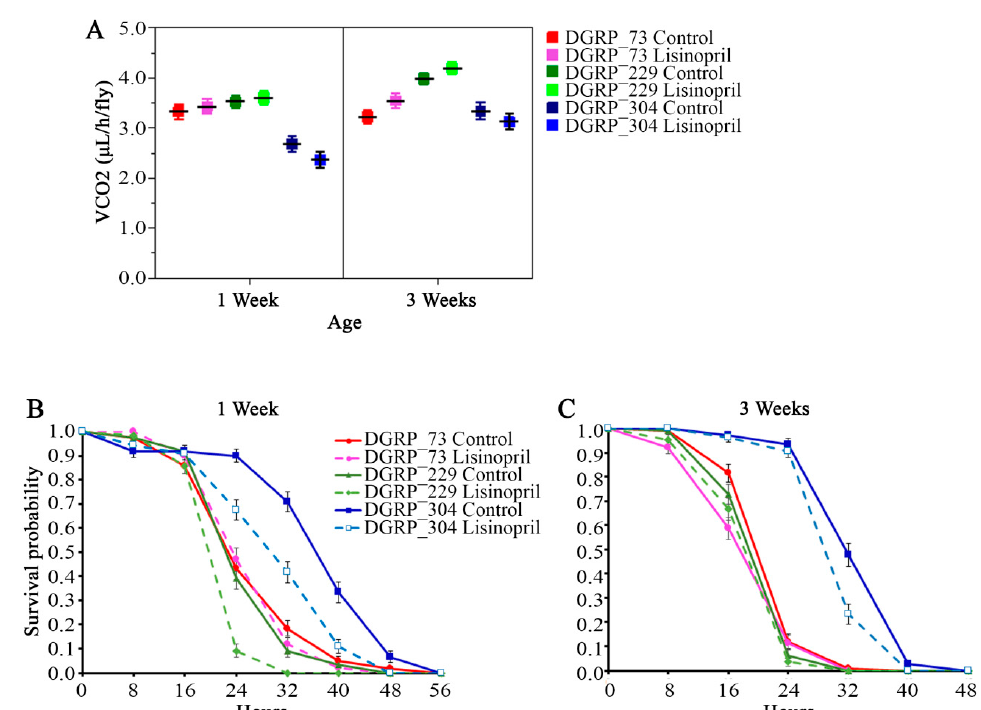
Figure 6. Lisinopril negatively affects survival under nutrient starvation but the effect of the drug can be blunted by genotype and age. ( A ) There is no significant effect of Lisinopril on resting metabolic rate (F 1,106 = 0.14, p = 0.7082). Values represent the least-square means of whole-body CO 2 production, an index of resting metabolic rate, adjusted for live body weight ( n = 10 independent replicates). ( B , C ) Kaplan–Meier survival probability curves for one-week-old (panel B ) and three-week-old (panel C ) DGRP flies fed Lisinopril or control food. There is a significant genotype-by-age-by-Lisinopril interaction effect on survivorship (Wald χ 2 = 7.53, p = 0.0061) in the analysis of pooled data. DGRP_229 and DGRP_334 fed Lisinopril are significantly more sensitive to starvation conditions than control flies at one week of age (Bonferroni corrected log-rank χ 2 = 28.00, p < 0.0001 and χ 2 = 30.19, p < 0.0001, respectively) (panel B ) but not at three weeks of age (panel C ). No statistically significant differences were observed for DGRP_73 flies.